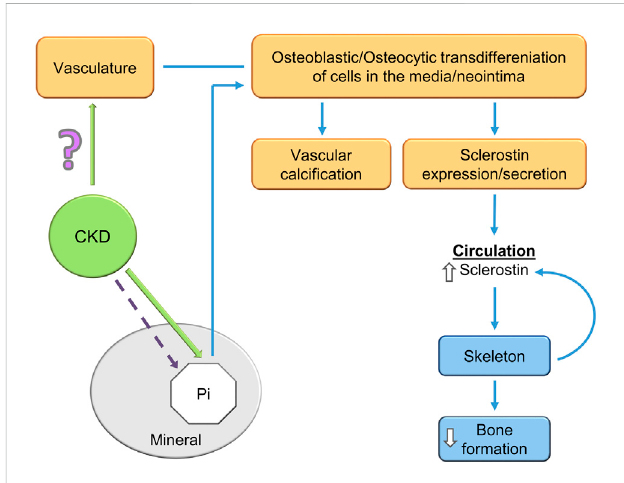
FIGURE 5 A potential explanation of the CKD-MBD bone-vascular paradox. CKD induces osteoblastic/osteocytic transdifferentiation of vascular smooth muscle cells. The osteoblastic/osteocytic cells stimulate vascular calci fi cation and express high levels of sclerostin as shown by Mace et al. (2021); Mace et al. (2022) and others. Sclerostin secretion to the circulation decreases skeletal remodeling and inhibits skeletal calci fi cation (an explanation of the paradox). Skeletal osteocytes also contribute to the elevated circulating sclerostin levels in CKD. How CKD stimulates VSMC transdifferentiation is unknown,